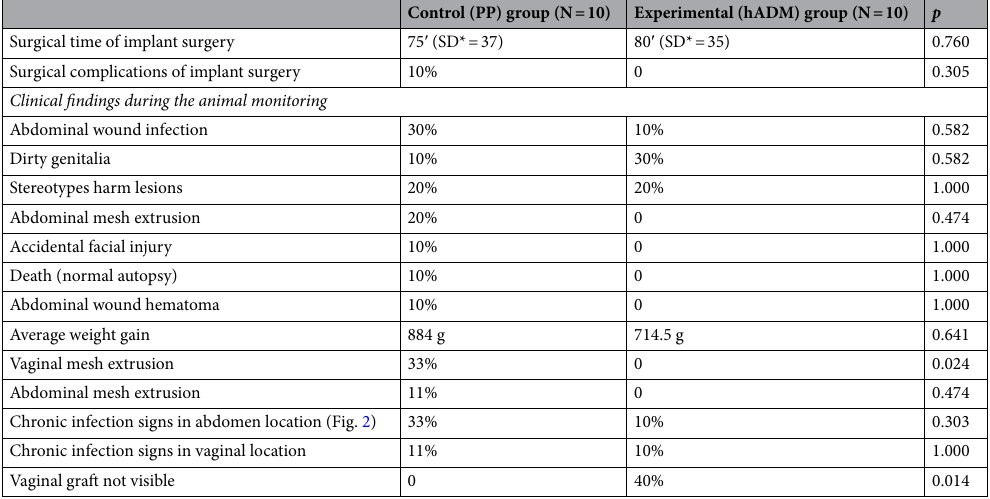
Table 1. Surgical variables, clinical findings during the animal follow-up and macroscopic study of explants. * SD Standard deviation.